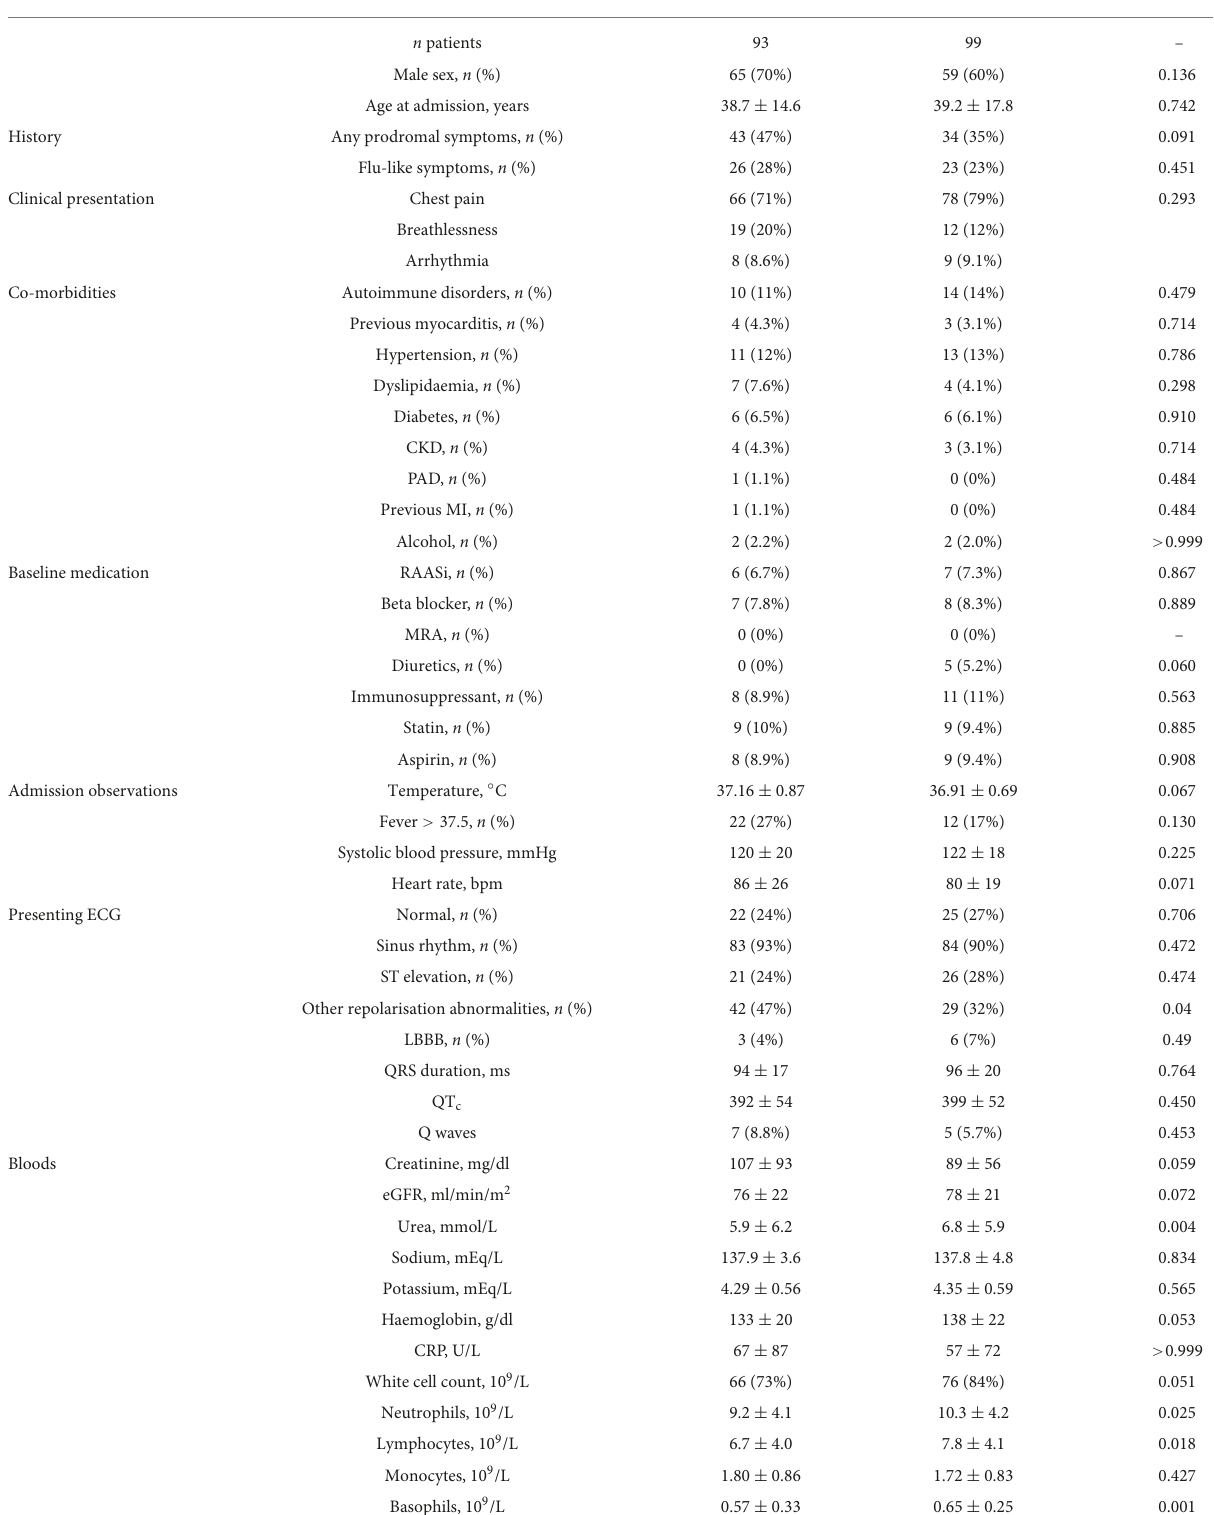
TABLE 3 Characteristics of study patients according to